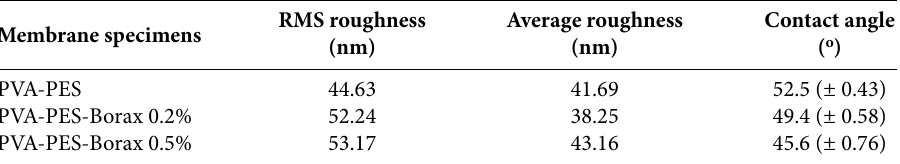
Table 2. Roughness parameters and contact angles of the membrane specimens in AFM image analysis (Sam- pling area 5 µm × 5 µm) (The figures in the bracket in column 4 indicate standard deviation.) Membrane